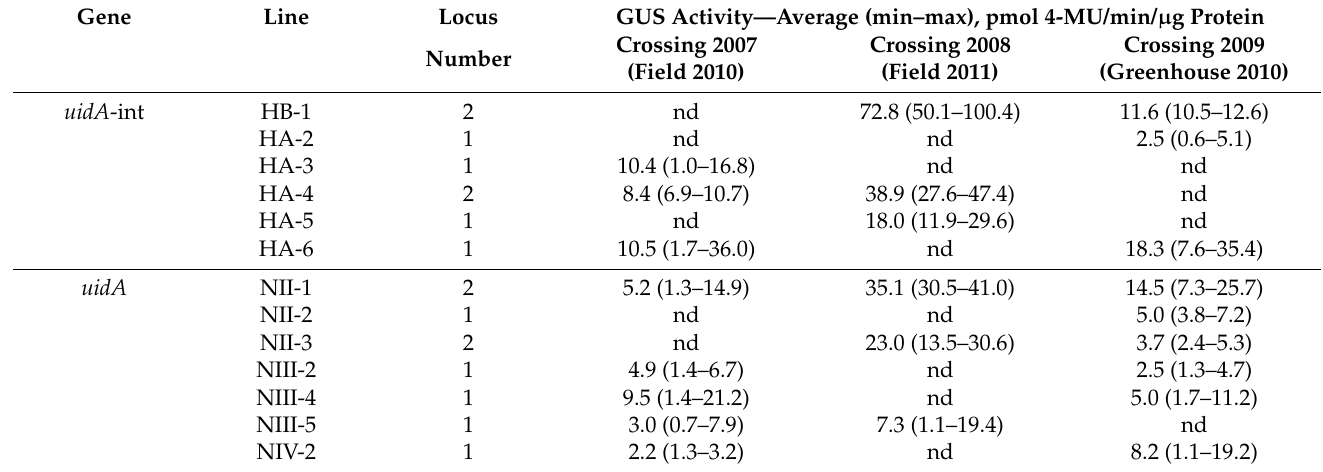
Table 5. Expression of uidA genes in the transgenic progeny of